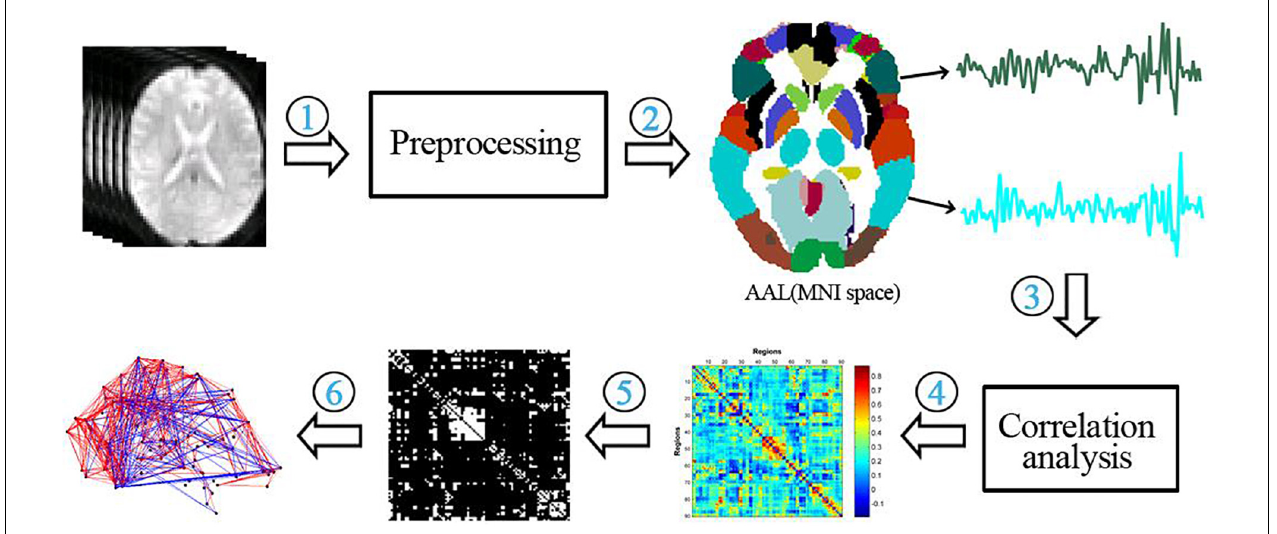
FIGURE 2 | Flow chart of the functional network analysis. (1) preprocessing of functional data; (2) extraction of temporal signals from 90 brain regions of the AAL template; (3) correlation analysis of temporal signals between brain regions; (4) construction of a functional connectivity matrix; (5) thresholding of the functional connectivity matrix; (6) calculation of network properties.